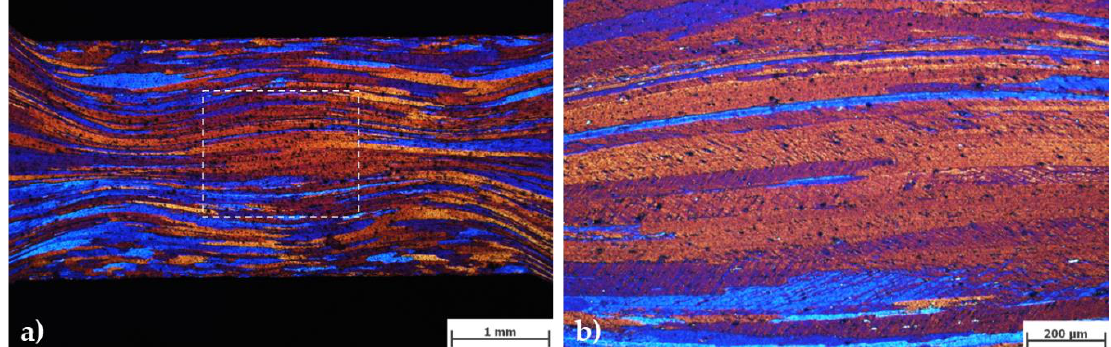
Figure 2. Elongated grains ( a ) and deformation bands ( b ) observed in the plane strain samples after cold deformation (optical microscopy). Nominal strain = 0.7.